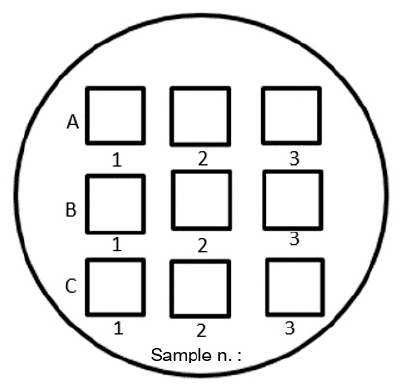
Figure 1. Distribution and indication of laser patterned samples.